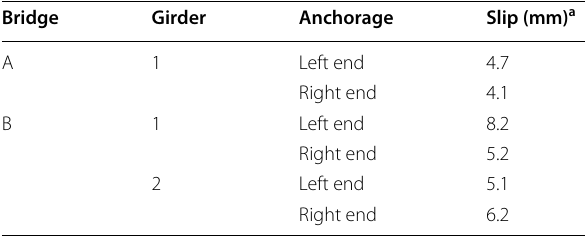
Table 4 Draw‑in slips at anchorages in bridges A and